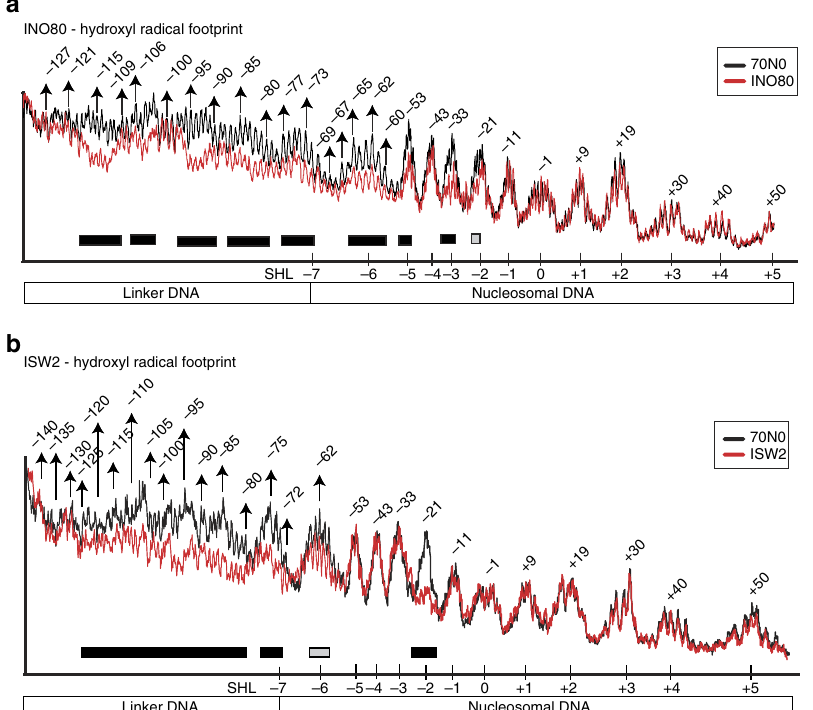
Figure 1 | INO80 protects nucleosomal DNA at SHL (cid:2) 3 and SHLs (cid:2) 5 to (cid:2) 6. Hydroxyl radical footprint of ( a ) INO80 and ( b ) ISW2 bound to nucleosomes (red), compared to nucleosome alone. SHL(s) and nucleotides are numbered with reference to the nucleosome dyad axis (0). Regions of strong and intermediate DNA protection are underlined, respectively, with black and grey bars. Data are representative of three technical replicates for both INO80 and